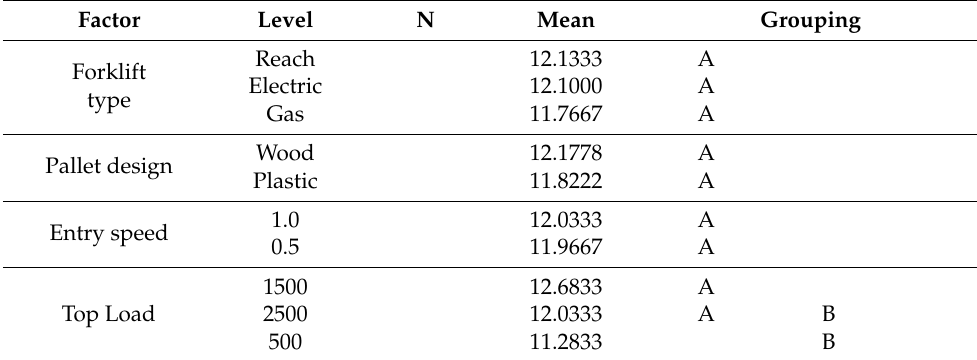
Means that do not share a letter are significantly different. Table A3. Tukey pairwise comparison for pallet duration response (Main effects).